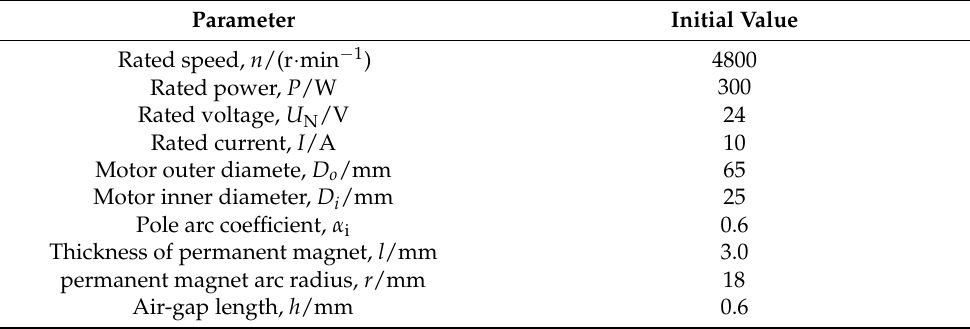
Table 1. Main parameters of